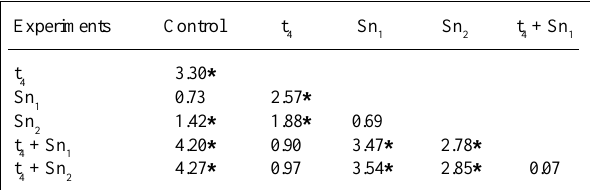
Table II - Multiple comparisons of Tukey for fecundity in the control and treated flies.